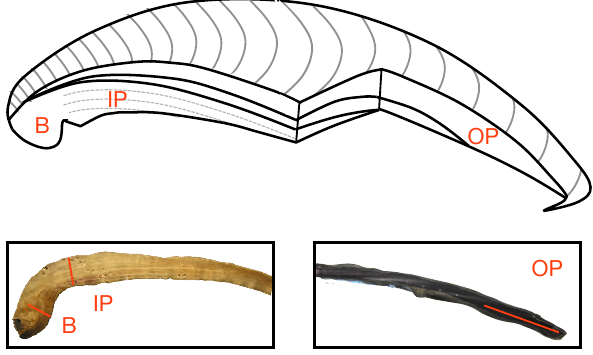
Fig. 1. A cross-sectional sketch of M. californianus , modified from Dodd (1964). Shell regions are labelled (B, beak; IP, inner pris- matic; OP, outer prismatic) in red. Sample transects are shown in red on the shell photographs